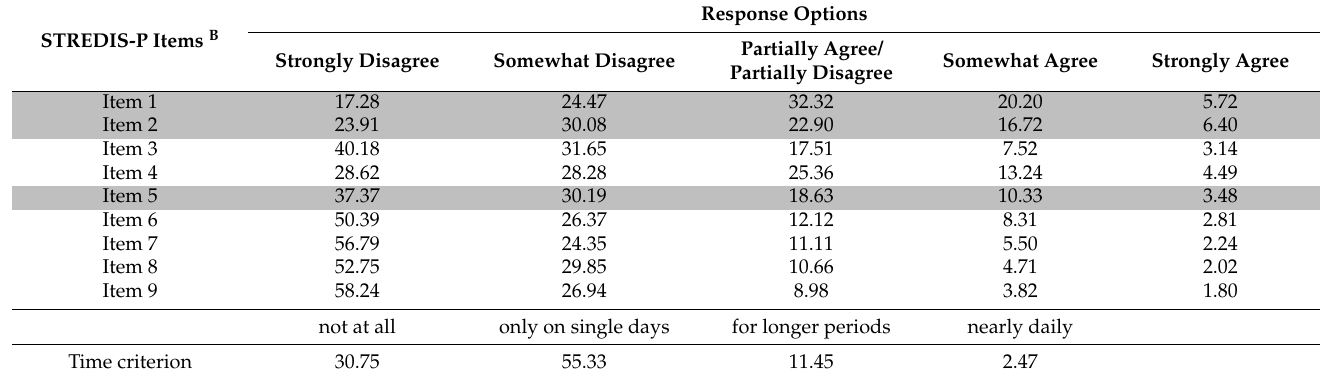
Table 4. Relative item-response frequency of STREDIS-P items (in %) a